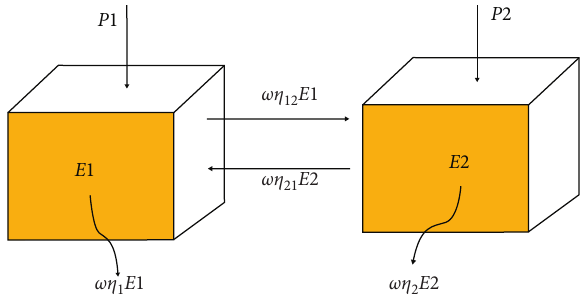
Figure 1: Energy analysis model of two subsystems.